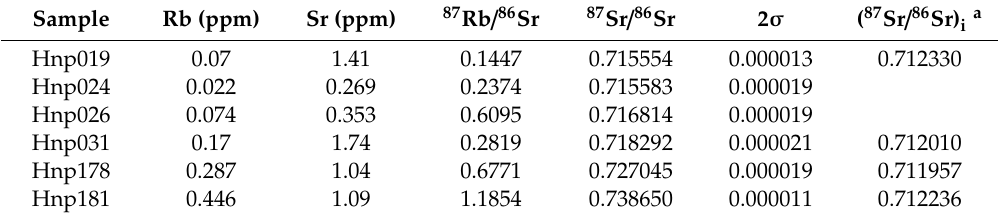
Table 2. Rb-Sr isotope data for pyrite from laminated ores in this study.